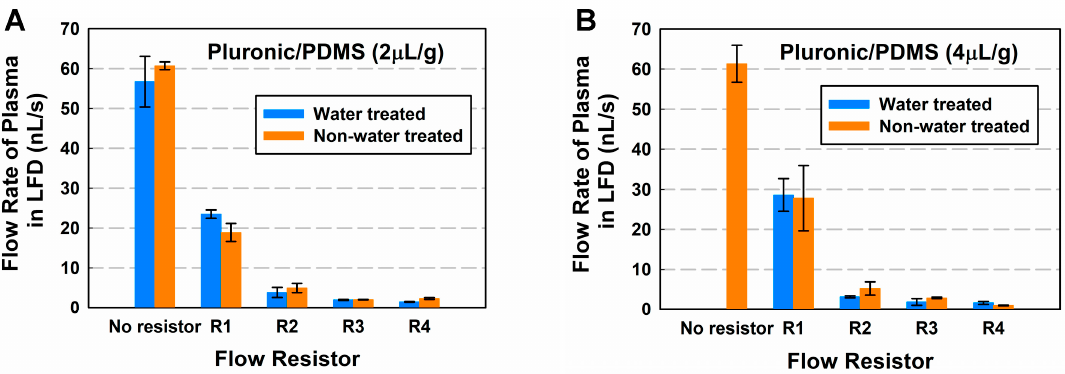
Figure 5. The flow rates of plasma in the entire LFD made of ( A ) Pluronic/PDMS (2 µ L/g); ( B ) Pluronic/PDMS (4 µ L/g). Table 6. Flow rates of plasma in the